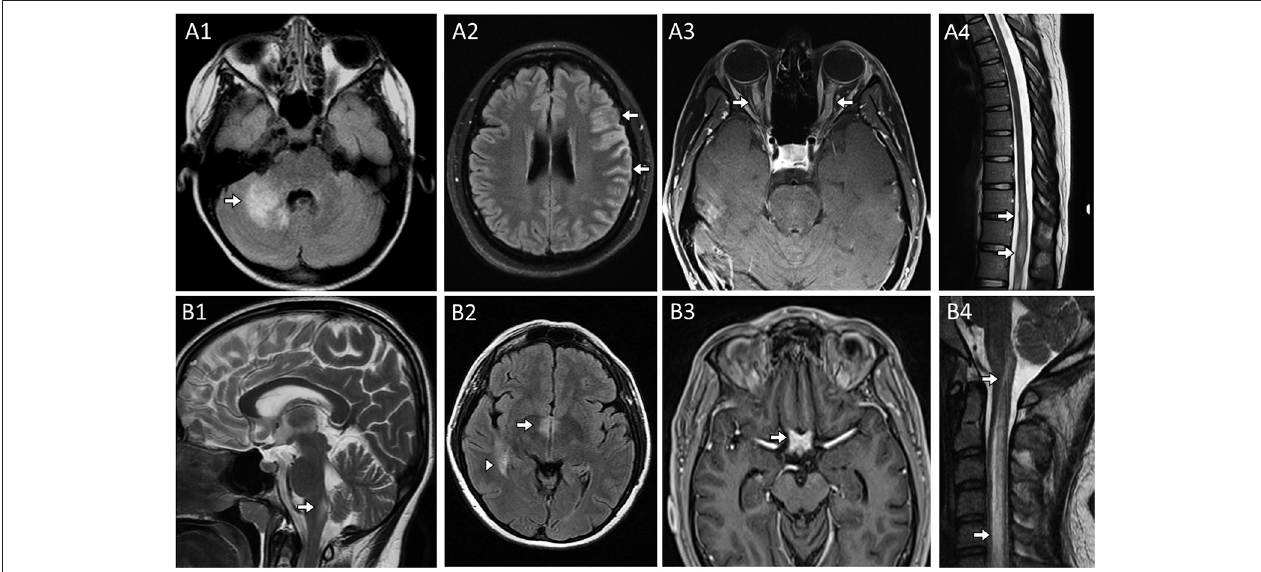
FIGURE 2 | MRI head, orbit, and spine examples in patients with CNS demyelinating disease from (A) Myelin Oligodendrocyte Glycoprotein-IgG antibody associated disorder and (B) Aquaporin-4-IgG seropositive neuromyelitis optica spectrum disorder. (A) Myelin Oligodendrocyte Glycoprotein-IgG (MOG) autoantibody associated disorder (MOGAD). Head MRI axial FLAIR images revealing characteristic large unilateral T2-hyperintense lesion in the right middle cerebellar peduncle with indistinct margins [ (A1) , arrow] in a patient a cerebellar attack and unilateral cortical T2-hyperintensities and swelling [ (A2) , arrows] in a patient with a unilateral cortical encephalitis attack. MRI orbits axial post-gadolinium images revealed bilateral anterior optic nerve enhancement with swelling [ (A3) , arrows] in a patient with bilateral optic neuritis. Thoracic spine MRI sagittal T2-weighted image reveals characteristic T2-hyperintensity with swelling within the conus [ (A4) , arrow] in the setting of a transverse myelitis attack. (B) Aquaporin-4-IgG seropositive neuromyelitis optica spectrum disorder. Sagittal T2-weighted brain image reveals T2-hyperintensity in the dorsal medulla adjacent to the 4th ventricle [ (B1) , arrow] in in a patient with an area postrema attack resulting in intractable nausea, vomiting and hiccups; MRI head axial FLAIR image reveals T2-hyperintensity adjacent to the 3rd ventricle [ (B2) , arrow] and an additional T2-hyperintense lesion in the medial temporal lobe [ (B2) , arrowhead]; MRI of the head and orbits with axial T1-weighted image post-gadolinium reveals enhancement of the optic chiasm [ (B3) , arrow]; Cervical spine MRI sagittal T2-weighted image reveals a longitudinal extensive T2-hyperintense lesion extending more than 3 vertebral segments [ (B4) , arrows] in a patient with a transverse myelitis